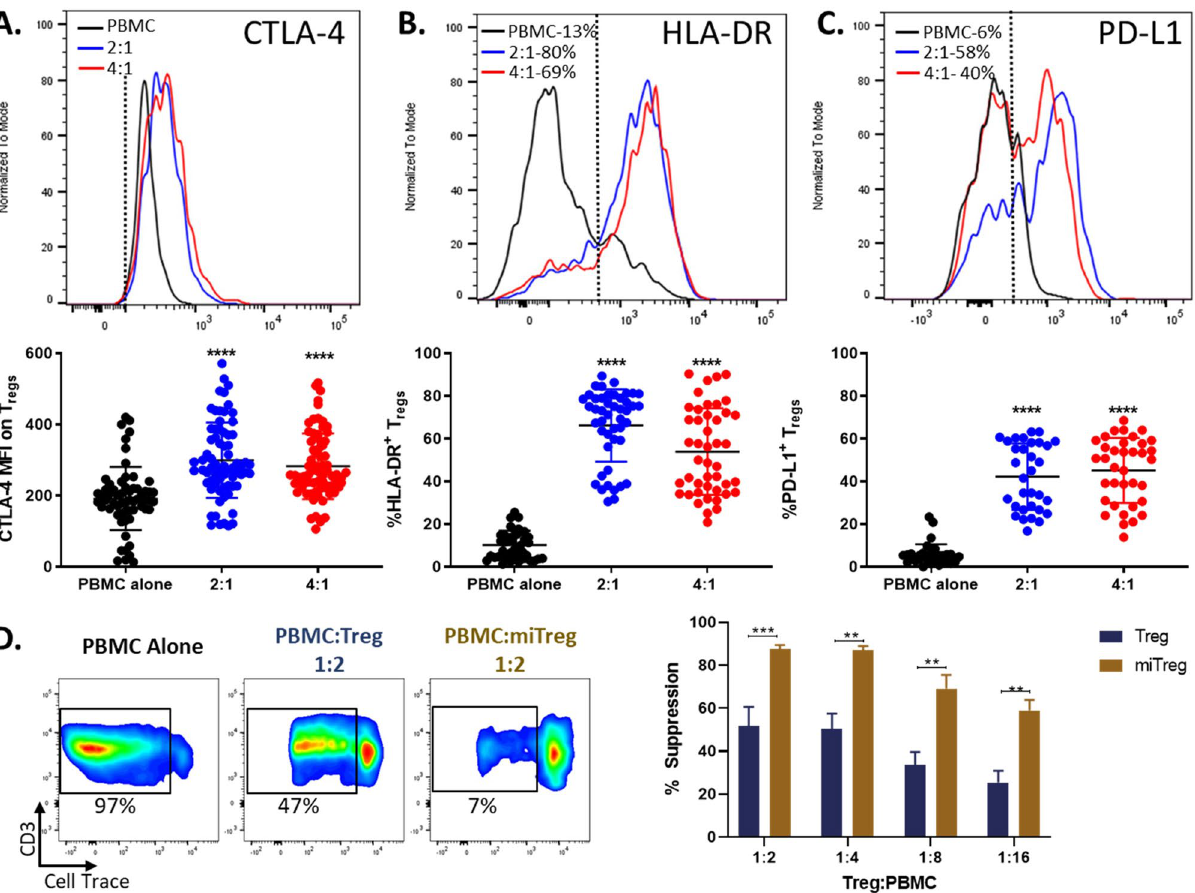
Figure 2. MAPC cells increase Treg suppressive phenotype and function capacity. Representative histogram depicting ( A ) CTLA-4, ( B ) HLA-DR, and ( C ) PD-L1 expression on Tregs from PBMC (black line), 2:1 (blue line), and 4:1 (red line) 7-day co-cultures. FMO shown as dotted line. Numbers represent the percent positive of corresponding marker within the Treg population. Graphs showing quantification of CTLA-4 (MFI), HLA-DR, and PD-L1 expression on Tregs. ( D ) Representative dot plots depicting CD3 + T cell proliferation in PBMCs cultured alone or PBMCs co-cultured with either Tregs or miTregs (1:2) after stimulation with anti-CD3/CD28. Quantification of suppression of T cell proliferation by Tregs (blue) or miTregs (gold) normalized to percent suppression. Data comprises 6 independent experiments from 6 healthy individual blood donors. Statistical analysis was performed using One-way ANOVA with a Tukey’s multiple comparisons test reference to the control PBMC alone (****p < 0.0001, ***p < 0.001, and **p <